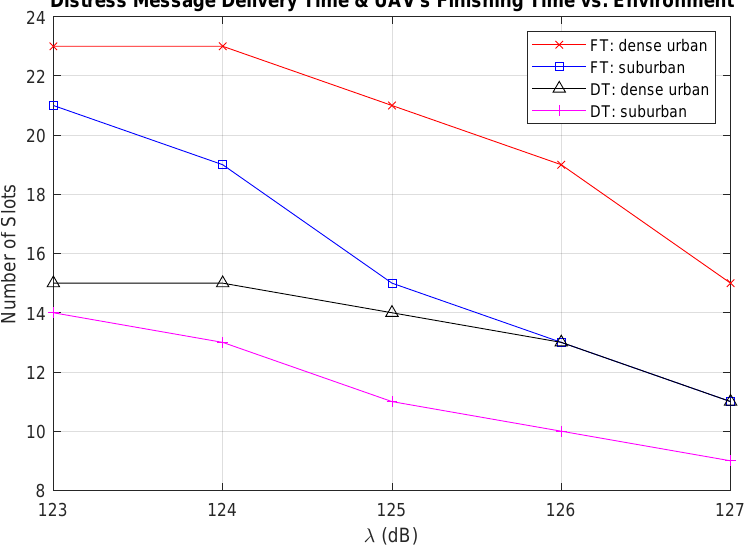
Figure 11. Finishing time vs. delivery time vs. the